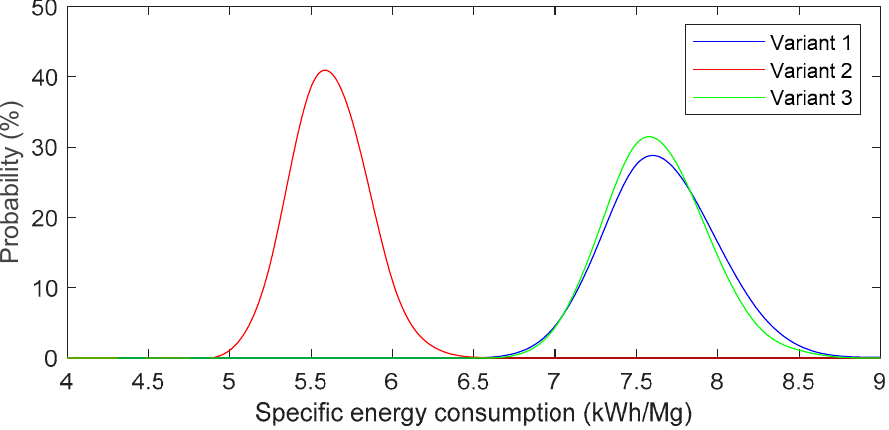
Figure 14. Probability distribution of specific energy consumption for the analyzed drive systems. Tables 2 and 3 show statistical parameters characterizing the obtained indicators and values of simulation errors: MAE (mean absolute error) and RMSE (root mean squared error).